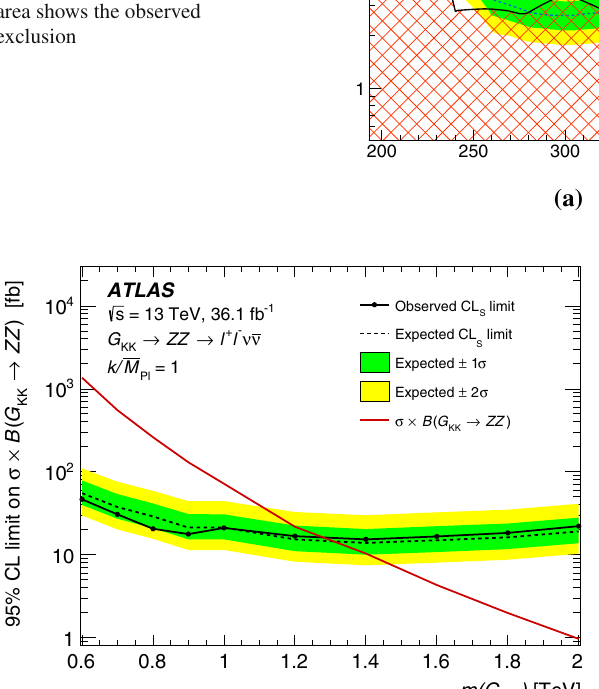
Fig. 9 The exclusion contour in the 2HDM a Type-I and b Type-II models for cos (β − α) = − 0 . 1, shown as a function of the heavy scalar mass m H and the parameter tan β . The green and yellow bands represent the ± 1 σ and ± 2 σ uncertainties in the expected limits. The hatched area shows the observed